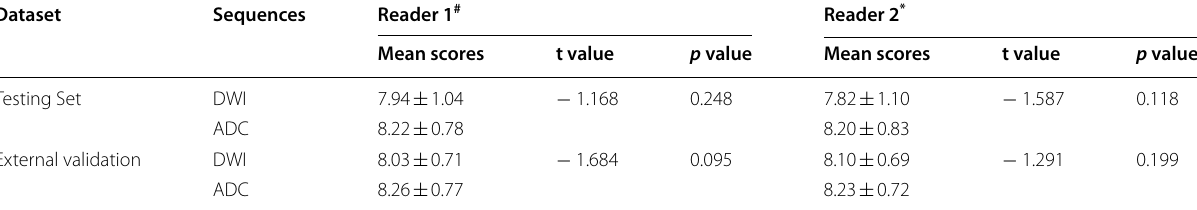
Unless otherwise specified, data are mean # Reader 1 refers to a radiology expert with more than 15 years of reading experience